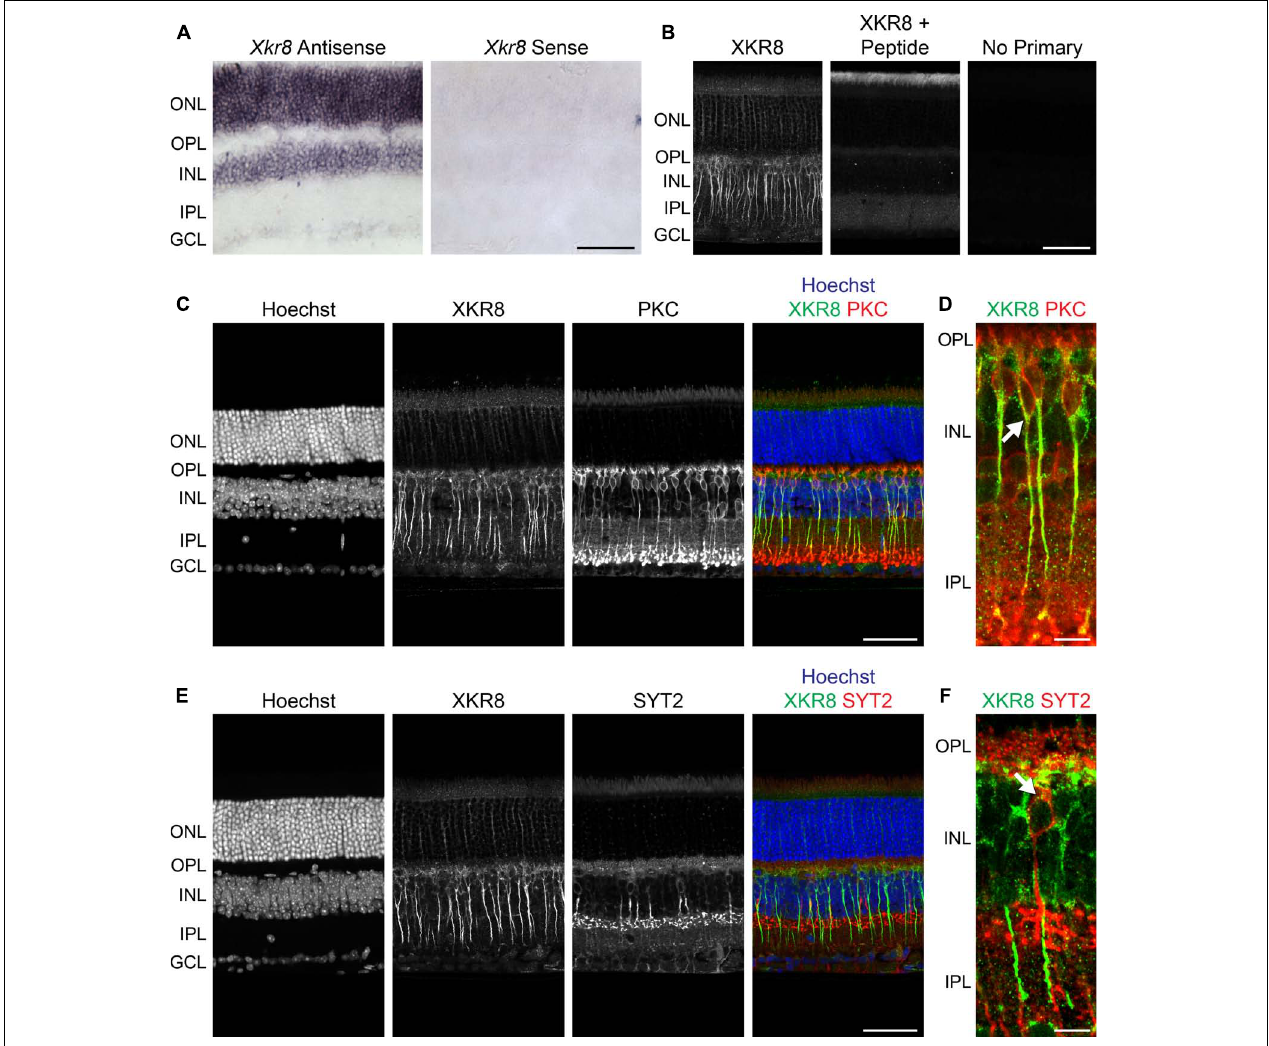
FIGURE 3 | (A) Xkr8 mRNA was localized in the mature B6/J mouse retina using in situ hybridization, evincing conspicuous expression in the ONL and INL, and weaker expression in the GCL (left). No signal was detected using the control (sense) riboprobe (right). (B) XKR8 immunofluorescence in the mature B6/J retina, showing prominent labeling of bipolar cell somata and axons, as well as lighter labeling of cells in the ONL and GCL (left). Positive control sections, in which the primary antibody was pre-absorbed with XKR8 peptide sequence (middle), and negative control sections, in which the primary antibody was omitted (right), showed abolition of labeling. (C) XKR8 labeling of bipolar cells includes the population of RBCs, though excluding their terminals in the IPL. (D) Higher magnification image showing XKR8 localized to RBC somata (e.g., arrow) and axons. Note as well-occasional XKR8-positive bipolar cells that are not RBCs (i.e., are PKC-negative). (E) XKR8 labeling is notably lighter in the membrane of CBC2 cells. (F) Higher magnification image showing XKR8 labeling in SYT2+ soma (arrow). Scale bar = 50 µ m for (A–E) ; = 10 µ m for (D,F) .